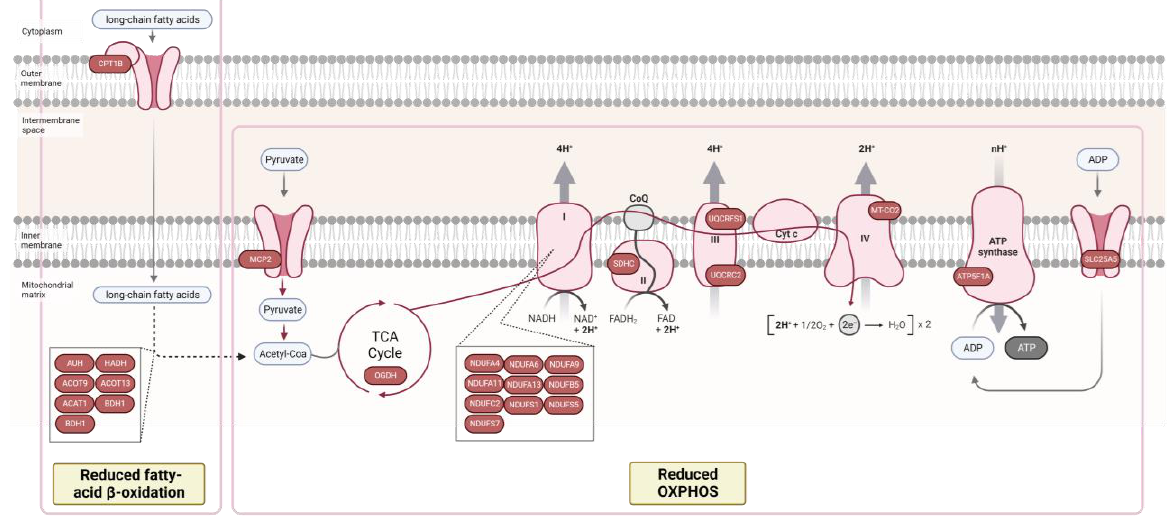
Figure 2. Proteomic analysis reveals decreased fatty-acid β oxidation and oxidative phosphorylation in myocardial tissue of patients with HFpEF + diabetes mellitus (DM). Proteins in the figure were identified as downregulated in HFpEF + DM group. Only proteins with a p - value ≤ 0.05 were included in the analysis. Figure adapted from “Electron Transport Chain”, by BioRender.com (2022). Retrieved from https://app.biorender.com/biorender-templates, accessed on 15 September 2022.